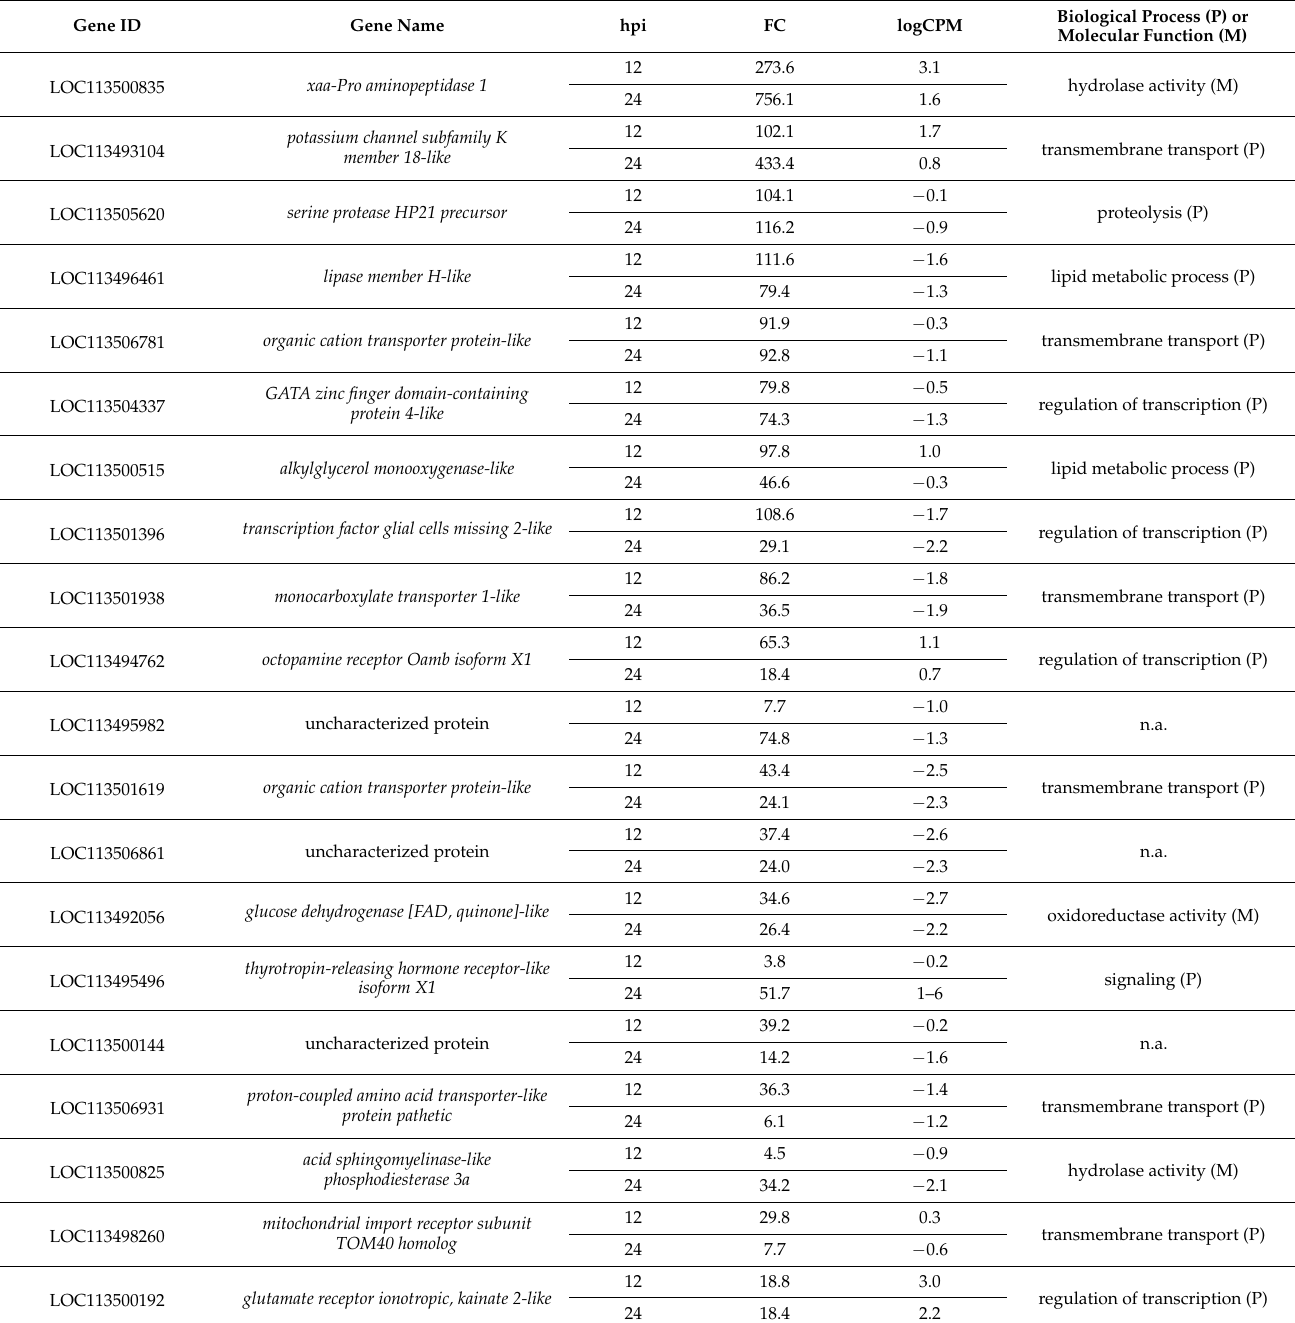
Table 1. List of TOP 20 up-regulated genes in adapted cells vs. non-adapted